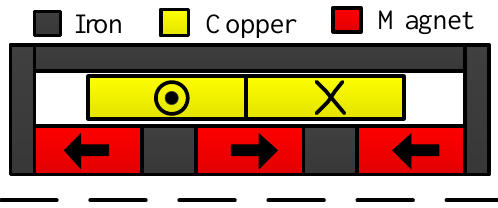
Figure 2. Sketch structure of the voice coil motor (VCM).